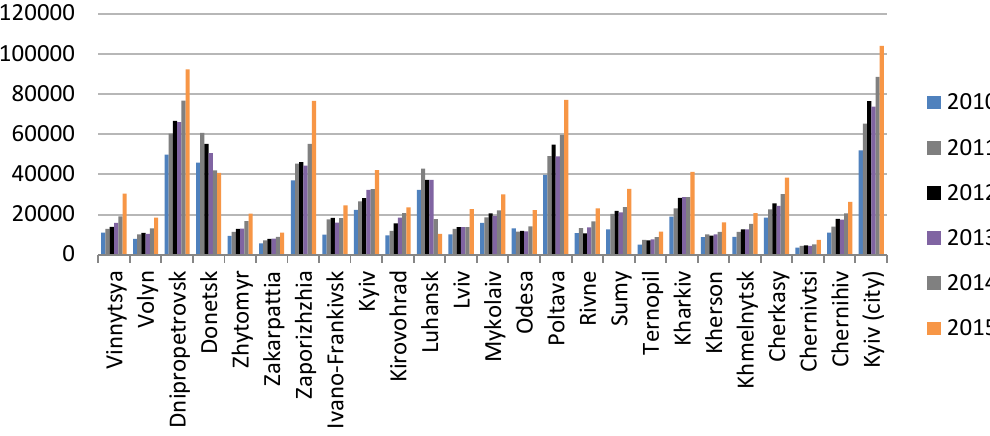
Fig. 5. The per capita sales volume for industrial products (goods, services) by region in 2010 – 2015, million UAH (based on data of the State Statistics Service of